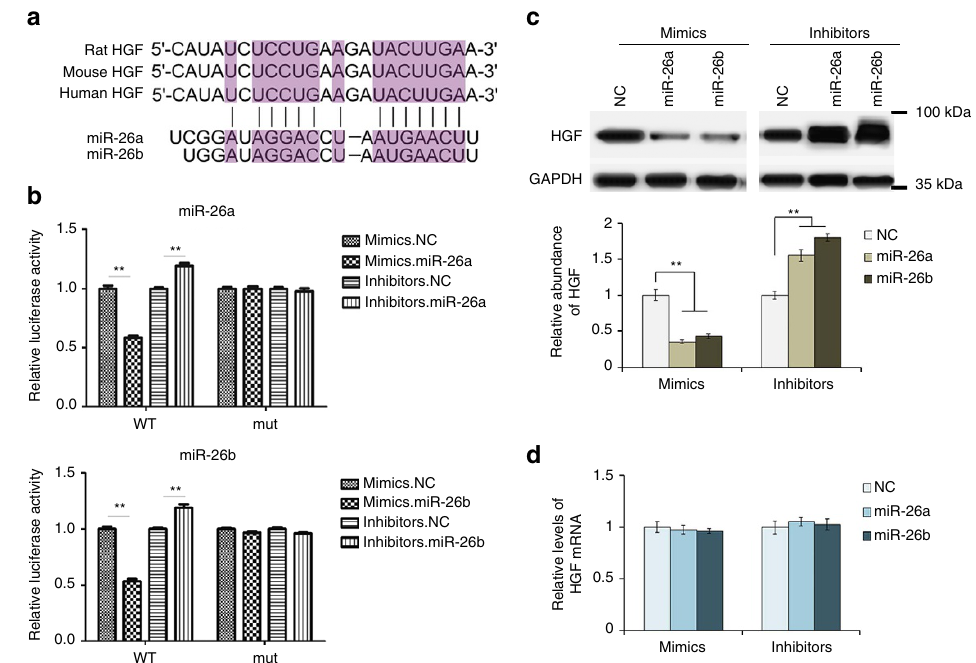
Figure 5 | Identification of HGF as a direct target of miR-26a/b. ( a ) Predicted binding sites of miR-26a/b within the 3 0 -UTR of HGF mRNA. ( b ) Direct recognition of HGF 3 0 -UTR by miR-26a and miR-26b. Primary liver cells were co-transfected with firefly luciferase reporters containing either wild-type or mutant (mut) HGF 3 0 -UTR with miR-26a/b mimics, inhibitors and the corresponding normal control. The relative luciferase levels were detected using a luciferase kit at 24–36h after transfection ( n ¼ 3). ( c ) Western blot analysis of HGF expression in primary liver cells with the overexpression or suppression of miR-26a or miR-26b ( n ¼ 3). ( d ) Relative levels of HGF mRNA in liver cells transfected with miR-26a/b mimics or inhibitors ( n ¼ 3). The data